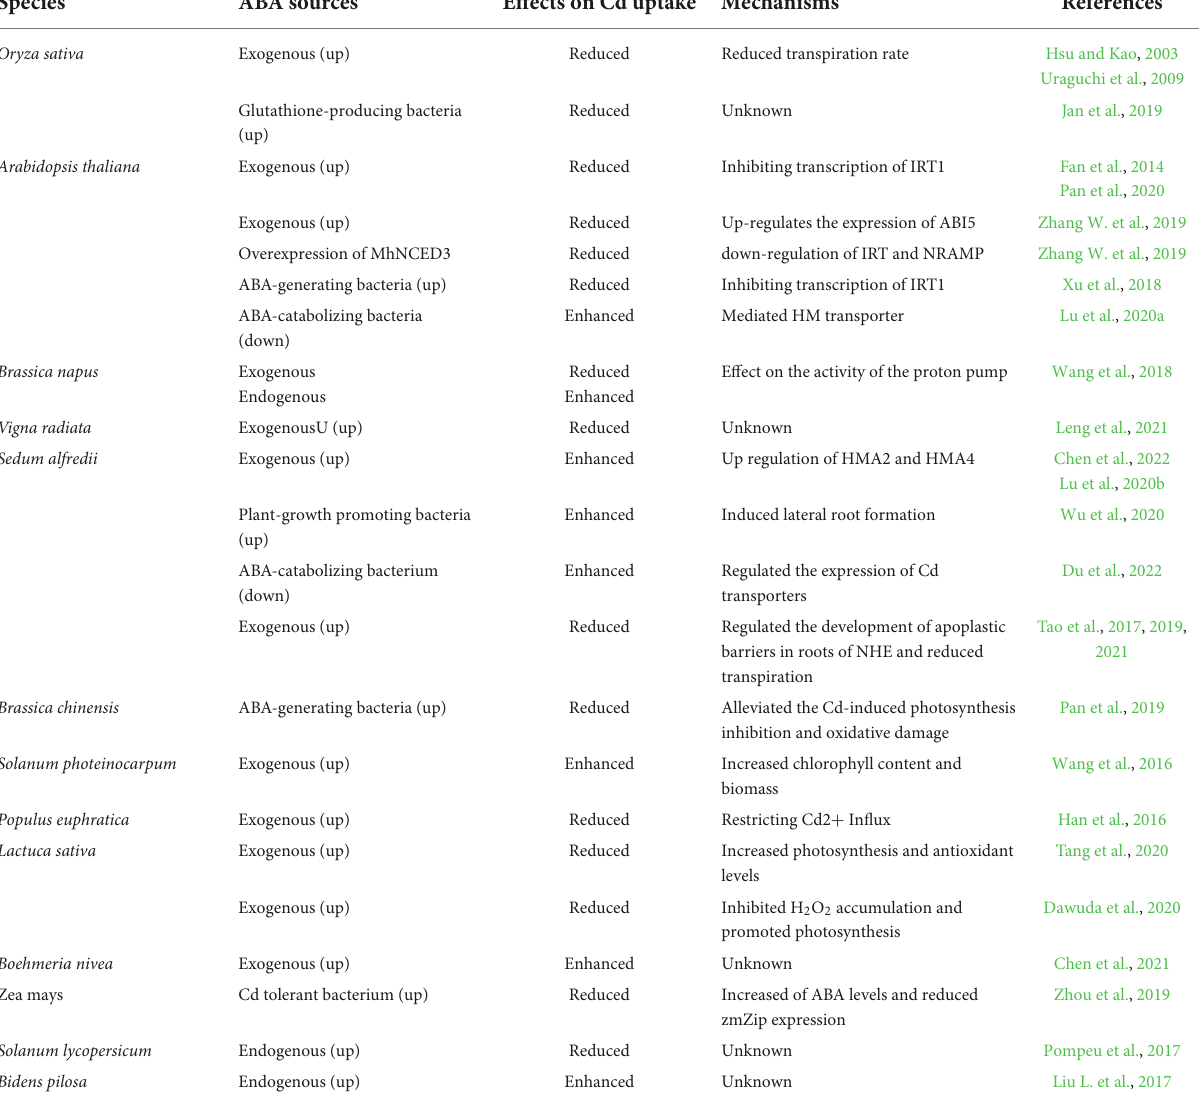
TABLE 1 Effect of abscisic acid (ABA) on Cd uptake capacity of different